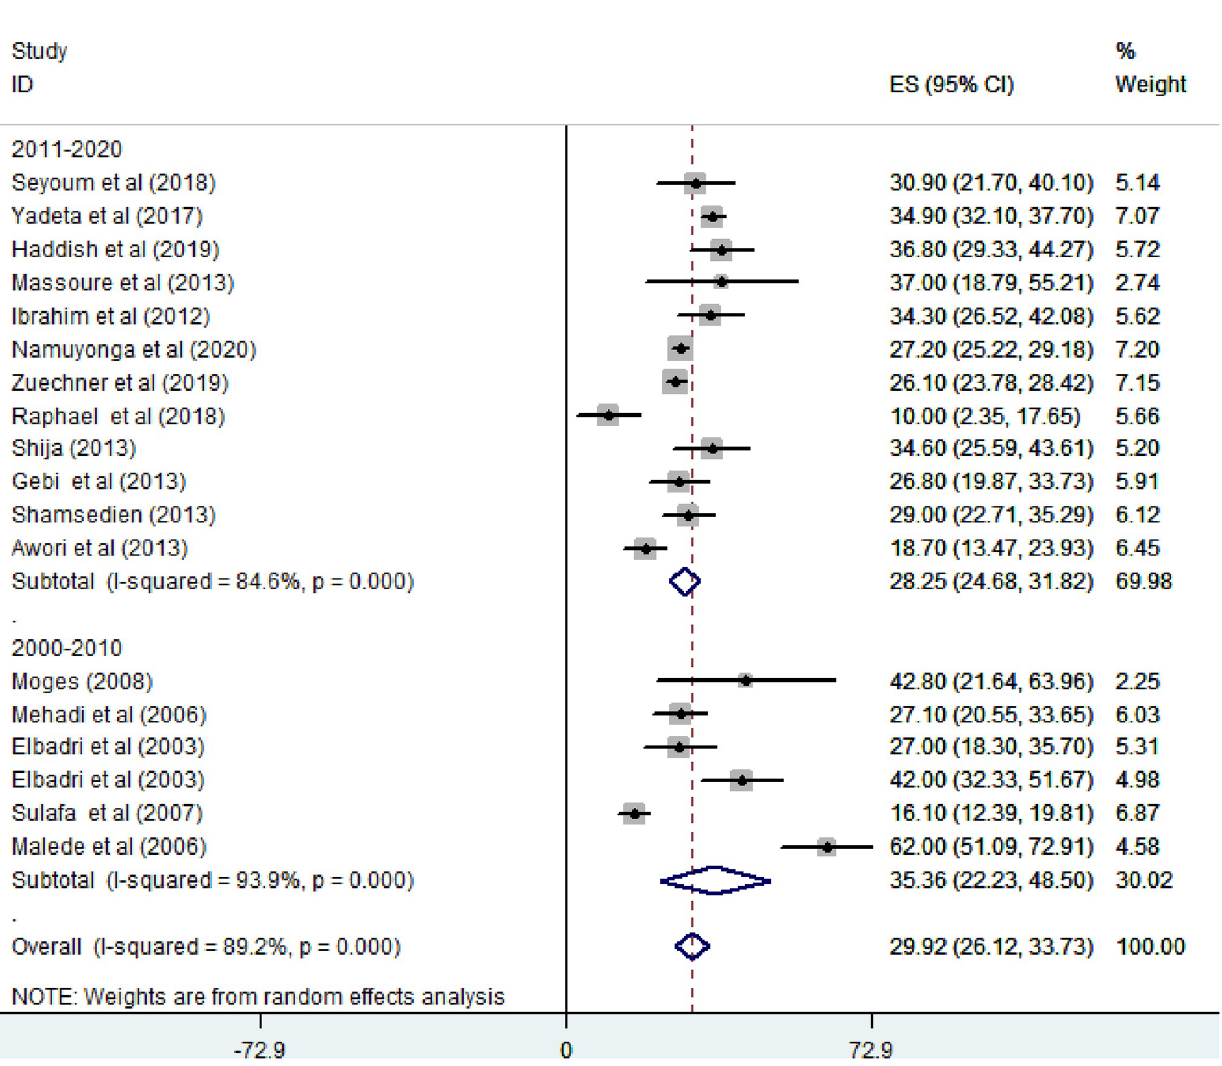
Fig 5. Forest plot showing subgroup analysis of the pooled magnitude of ventricular septal defect among congenital heart defect patients by year of publication in East Africa, from January 2000-October 2020.